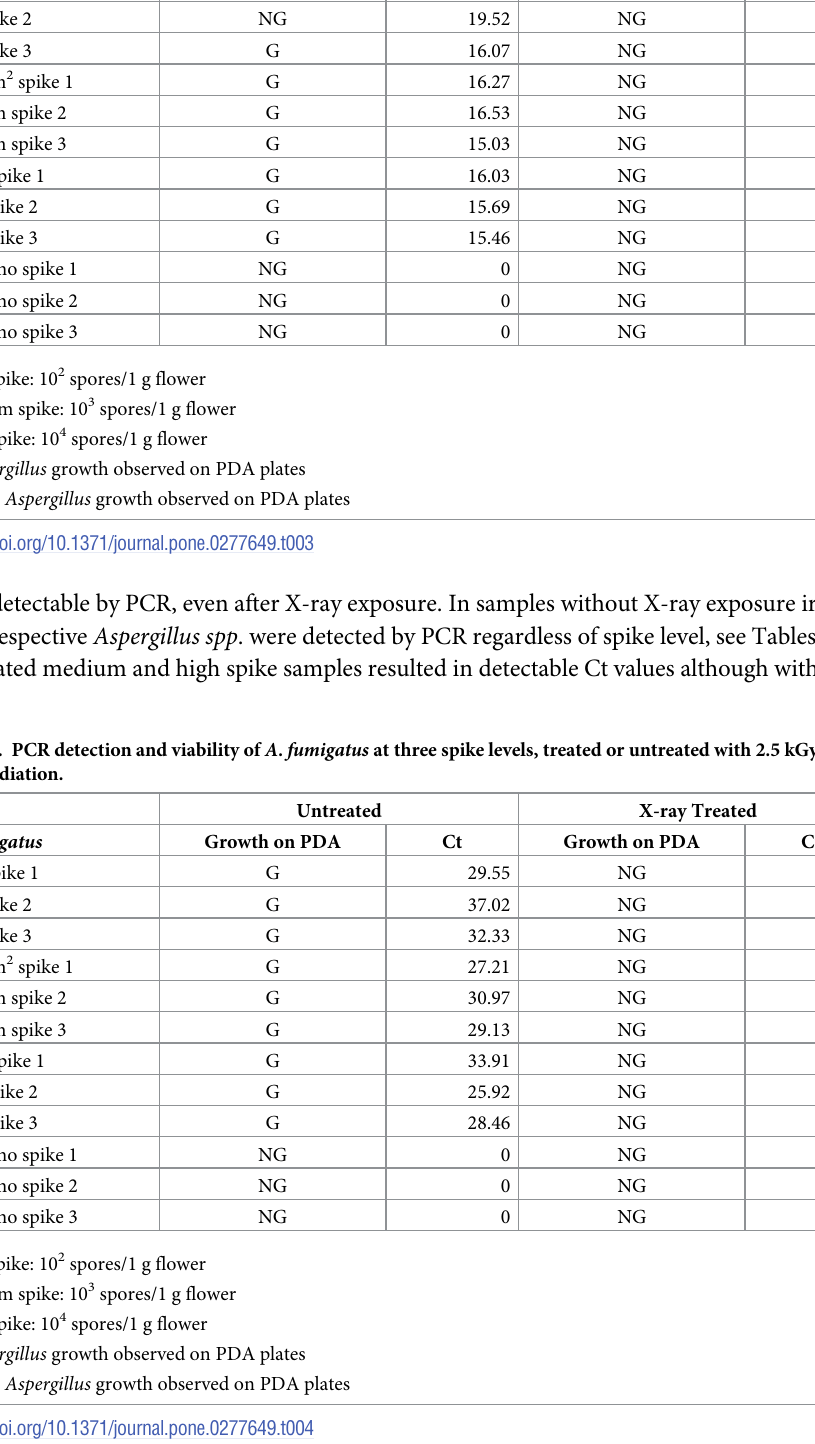
Table 3. PCR detection and viability of A . niger at three spike levels, treated or untreated with 2.5 kGy of X-ray irradiation. Untreated X-ray Treated A . niger Growth on PDA Ct Growth on PDA Ct